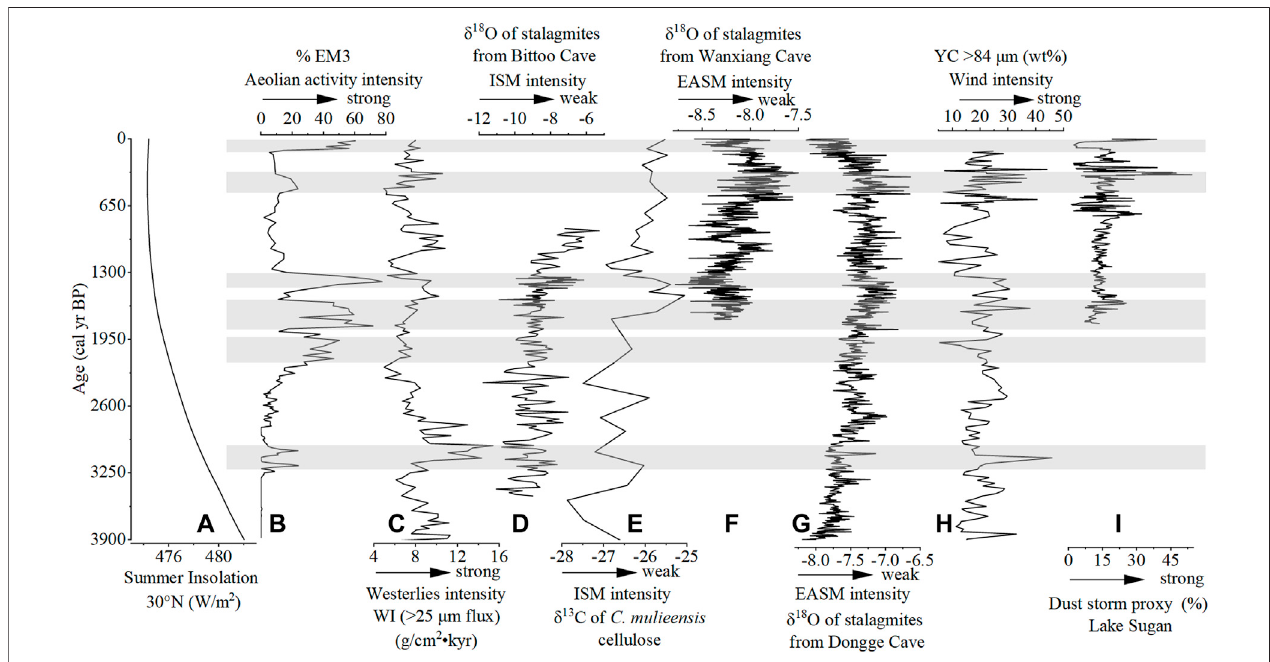
FIGURE 9 | (A) Summer insolation at 30 o N (Berger and Loutre 1991). (B) EM3 fraction. (C) Westerlies climate index (WI, fl ux of > 25 μ m fraction) in Qinghai Lake; large WI values indicate strengthened westerlies in fl uence (An et al., 2012). (D) δ 18 O of stalagmites from the Bittoo Cave (Kathayat et al., 2016). (E) δ 13 C curve of the C. mulieensis remains and mixed plant cellulose of the Hongyuan peat, the smaller the δ 13 C of peat plant remains cellulose, the stronger the monsoon activity is and vice versa (Hong et al., 2003). (F) δ 18 O of stalagmites from the Wanxiang Cave (Zhang et al., 2008). (G) δ 18 O of stalagmites from the Dongge Cave (Wang et al., 2005). (H) Dust storm record from the Tarim Basin (Han et al., 2019). (I) Coarse fraction (56 – 282.5 μ m) of the sediments of Lake Sugan (Chen et al., 2013). The gray bars indicate the aeolian activity events.